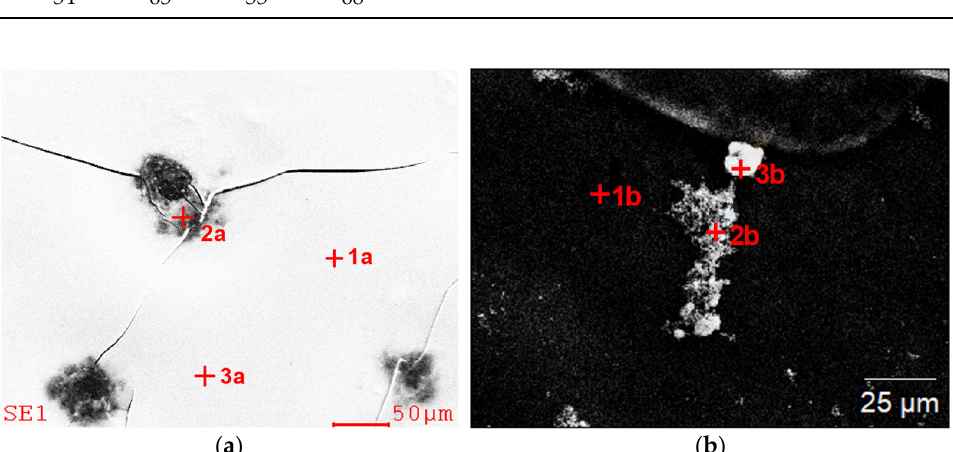
Figure 4. SEM images with marked chemical composition analysis points (results are presented in Table 2), dried specimen made from the control solution; ( a ) undiluted, ( b ) diluted.